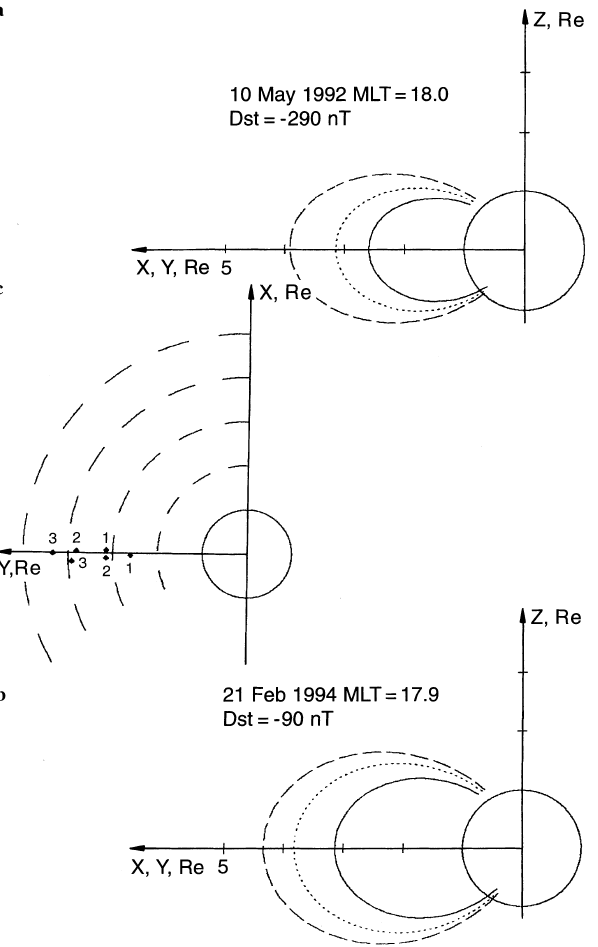
Fig. 8a–b. The mapping of the center and boundaries of eastward electrojets to the magnetospheric meridional ( a and b ) and equatorial c (for both a, b events) cross sections using the paraboloid model of the magnetospheric magnetic field.